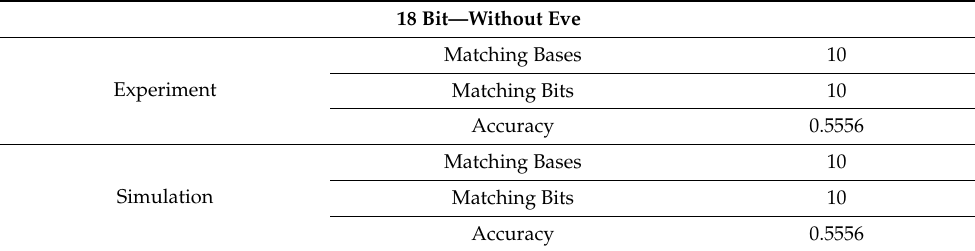
Table 3. An 18 bit accuracy for experiment and simulation—without